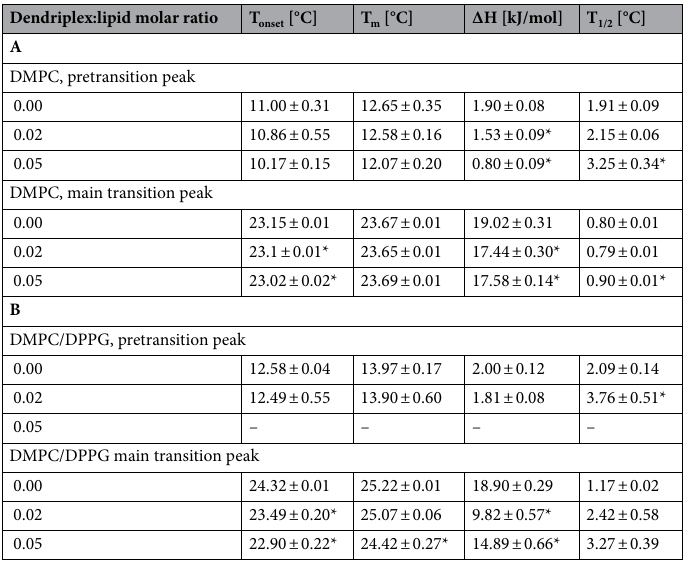
Table 1. DSC parameters of Gp160/CPD-G3 dendriplexes interaction with (A)—DMPC (5 mg/ml) and (B)— DMPC:DPPG (9:1 w/w, 5 mg/ml) lipid membranes. Calorimetric parameters: T onset —temperature at which the thermal effect starts; T m —temperature at which heat capacity at constant pressure is maximum; ΔT 1/2 —half width of the peak transition; ΔH—transition enthalpy. Errors express as SEM, n = 3. *Statistically significant difference at * p < 0.05 compared to lipid membranes without dendriplex